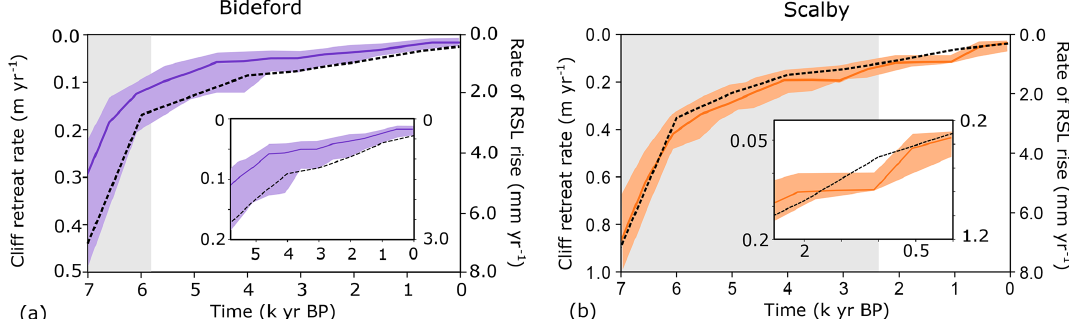
Figure 7. A time series of cliff retreat rate (myr − 1 ) shown by the solid line and shaded area across the late Holocene (from 7000 years BP to the present day) calculated from modelled cliff positions every 100 years. The first 1kyr is excluded as this corresponds to the burn-in period of the model. The rate of RSL rise (mmyr − 1 ) is shown alongside cliff retreat rates by the dashed black line. Inset plots show the cliff retreat rates and rate of RSL rise for the time period that corresponds to the distance across the shore platform over which measured data were analysed ( ∼ 250m). For Bideford (a) , the past 5800 years of modelled cliff retreat correspond to the 250m intertidal shore platform. For Scalby (b) , the past 2700 years of modelled cliff retreat correspond to the 250m intertidal shore platform. The grey shaded area corresponds to the cliff retreat rates which occurred further offshore than where the measured data were collected, and the non-shaded area shows the extent of the inset